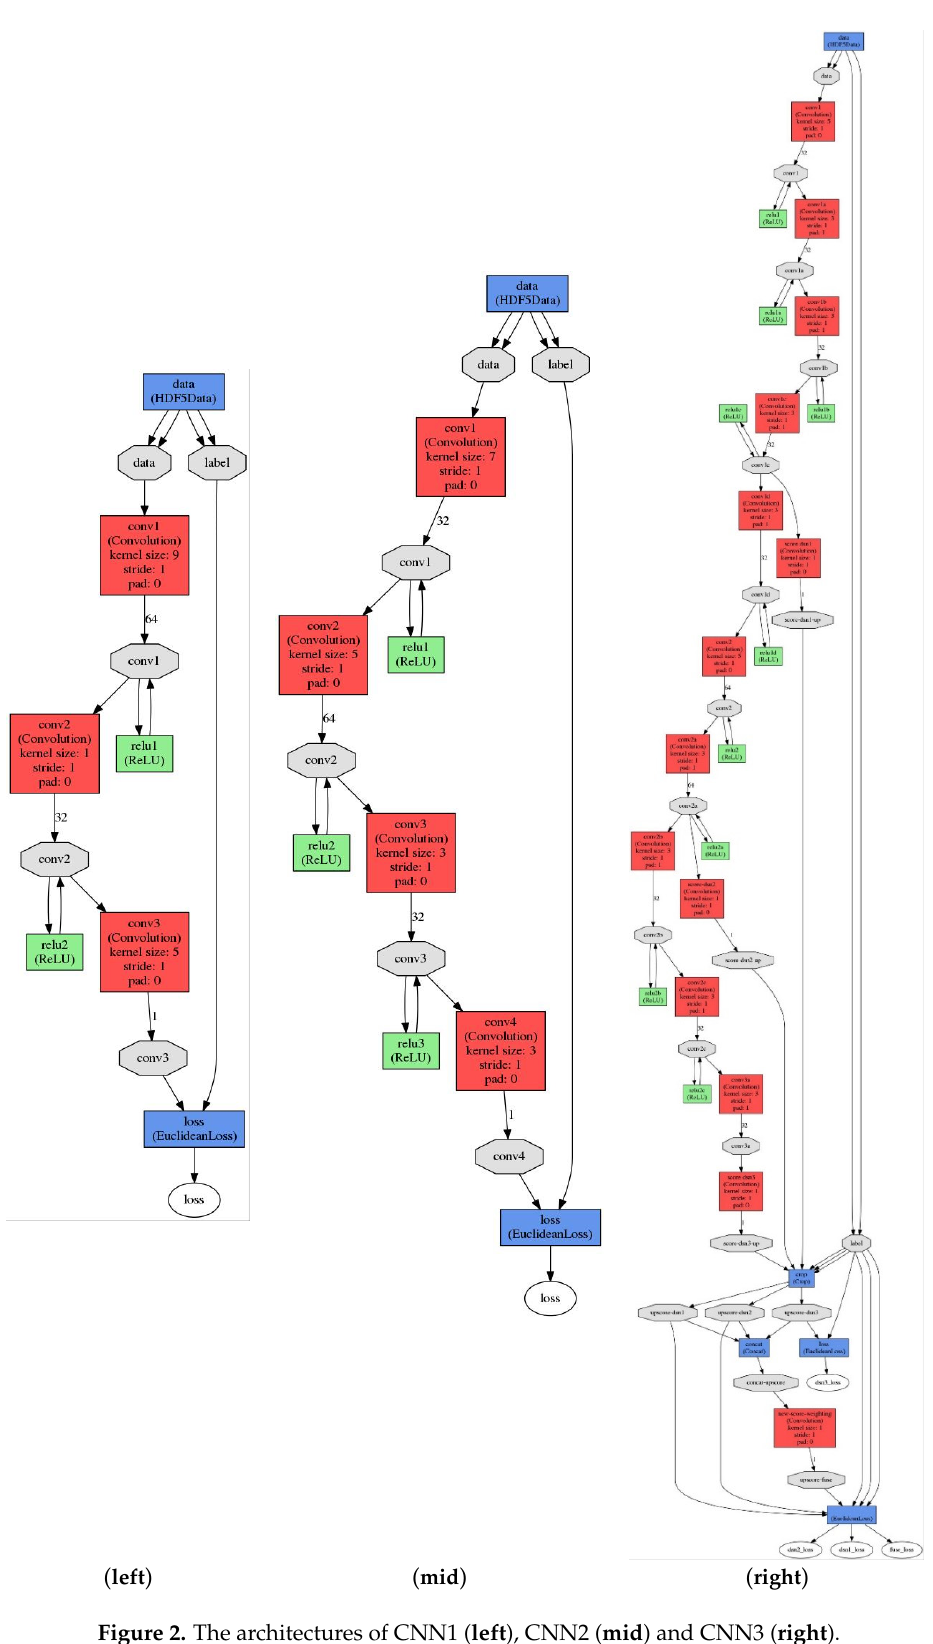
Figure 2. The architectures of CNN1 ( left ), CNN2 ( mid ) and CNN3 ( right ).